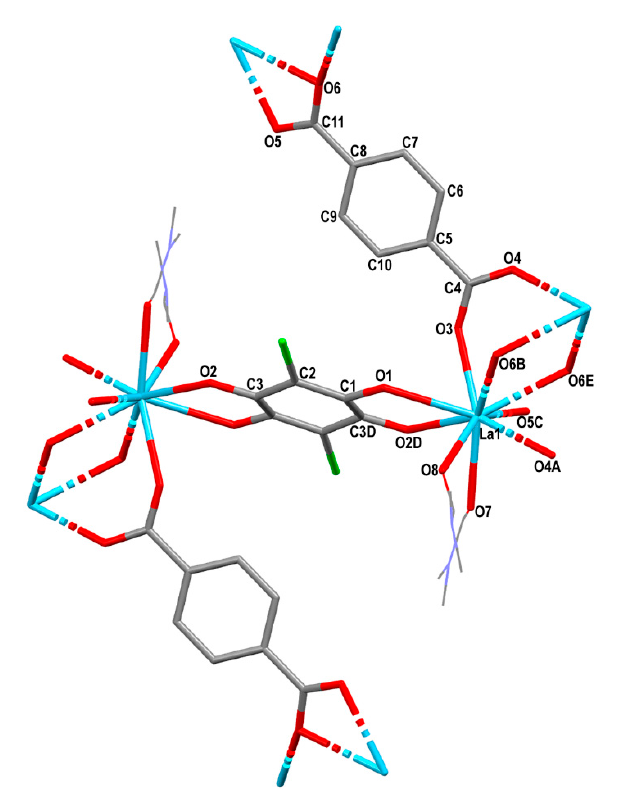
Figure 2. The molecular structure of the crystallographic unit in 3 . Color code: La, light blue; C, gray; Cl, green; O, red; N, violet.